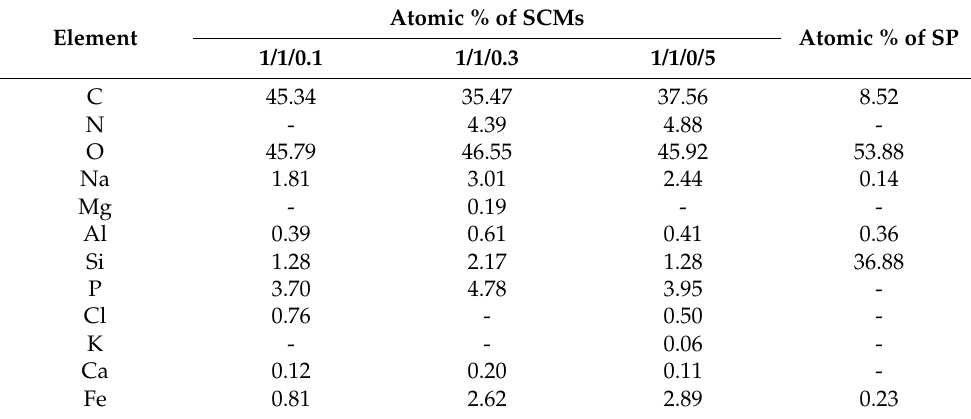
Table 2. EDS results for the SCMs and SP.